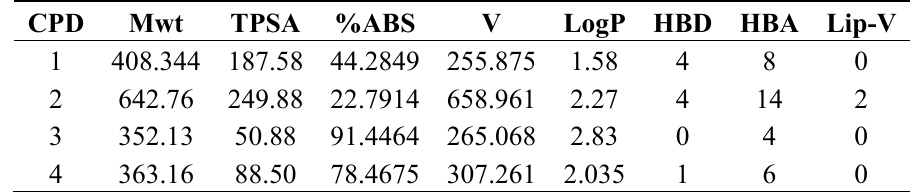
TPSA : Polar surface area; % ABS : absorption percentage; Log P : Calculated lipophilicity; LogS :